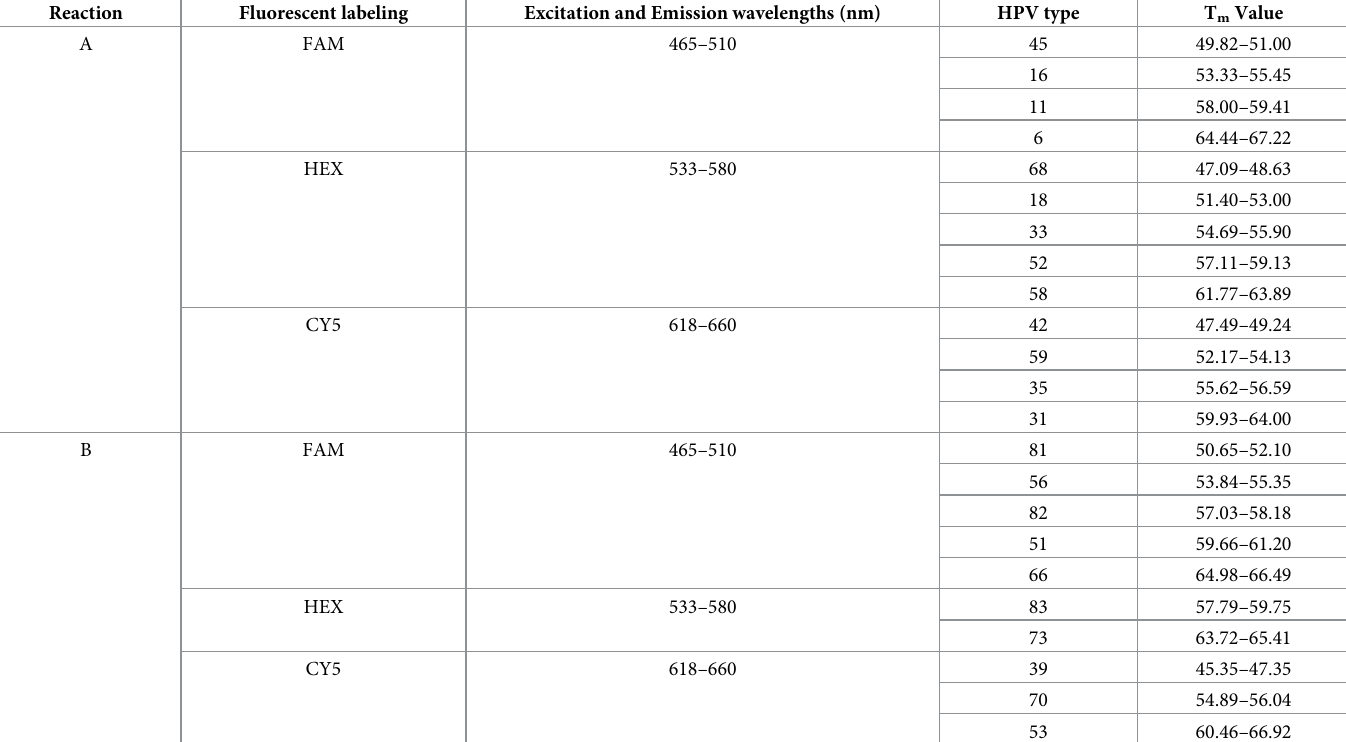
Table 2. T m value of each HPV type.